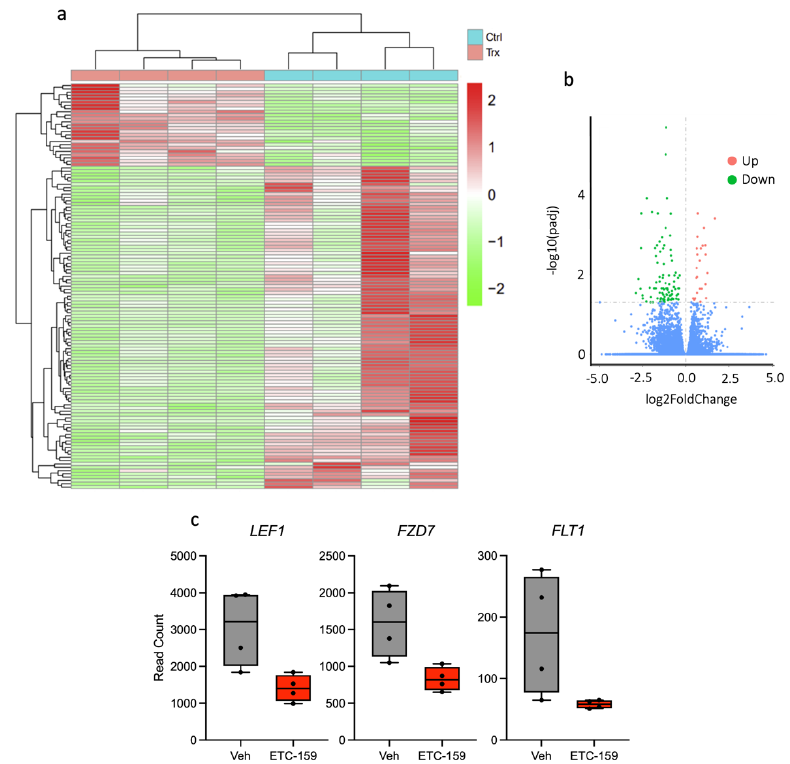
Figure 4. Analysis of differentially expressed genes in OS xenograft following ETC159 treatment. ( a ) A total of 123 differentially expressed genes (DEGs) with any fold change (adjusted p -value < 0.05) in osteosarcoma xenografts (n = 4) treated with ETC-159 were noted. A total of 25 genes were upregulated while 98 genes were downregulated. ( b ) Volcano plot summarizing genes differentially expressed in xenografts (n = 4) after treatment with ETC-159. ( c ) Significant downregulation of LEF1, FZD7, and LEF1 in OS xenograft after treatment with ETC-159 (adj. p -value < 0.05). LEF1 and FZD7 , which are associated with Wnt signalling, were downregulated less than 2-fold, while FLT1 , which is associated with angiogenesis, was downregulated more than 2-fold.